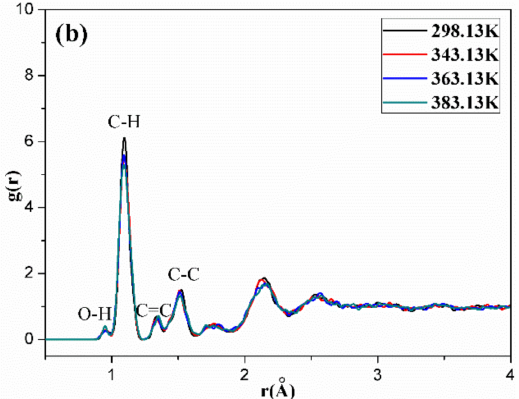
Figure 12. The radial distribution functions (RDFs) of carbon atoms (C–C) in the OH-NBR model in the uncompressed ( a ) and compressed ( b ) states.